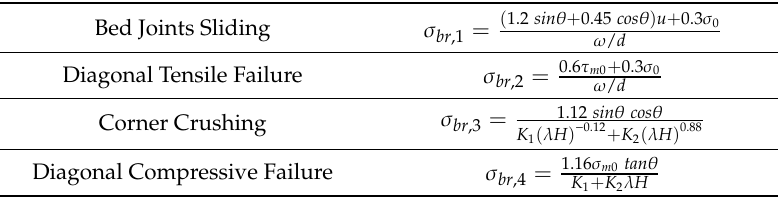
Table 4. Decanini et al. Failure Modes adapted from